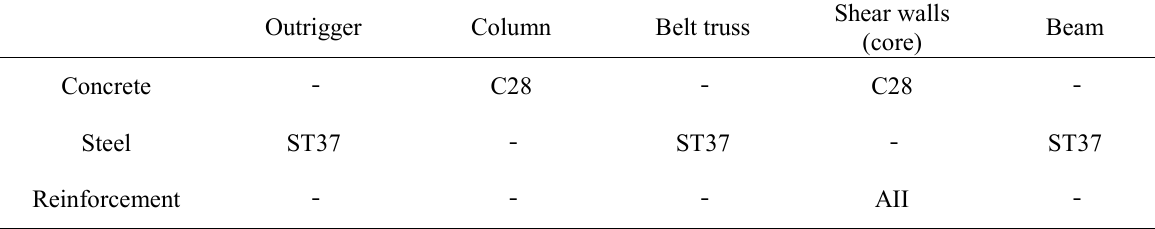
Material Properties.